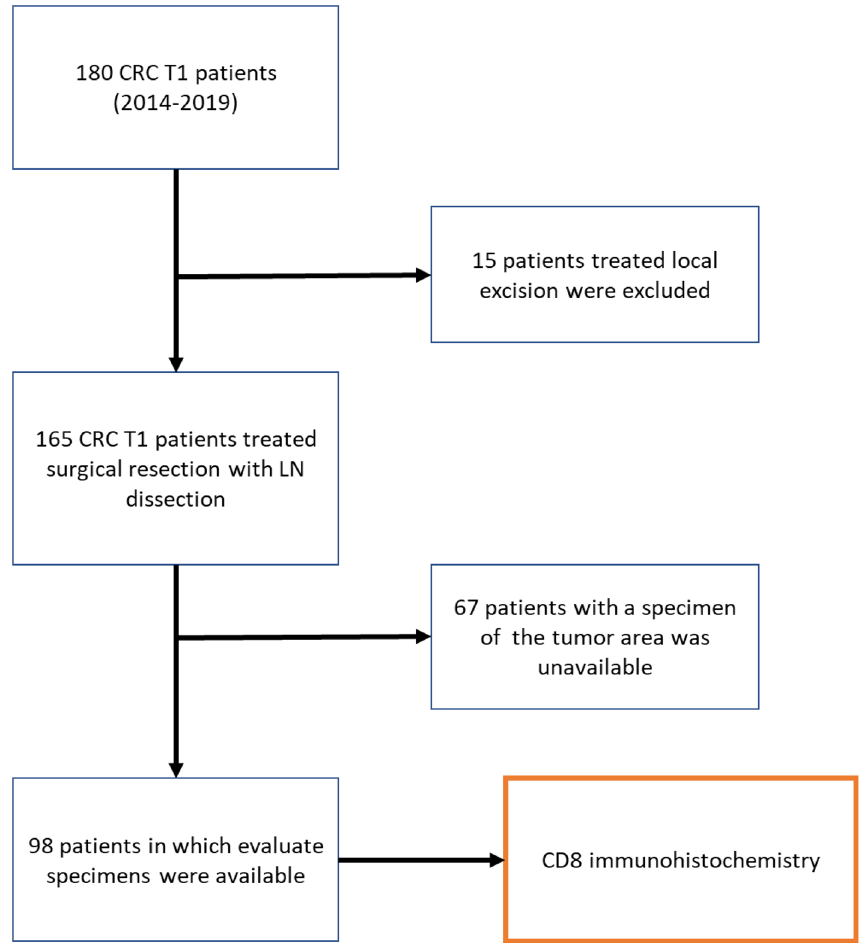
Figure 1. Scheme of the study. A total of 180 patients with surgically treated SM-CRC were enrolled in this study; 15 patients treated with local excision that lacked pathological lymph node metastasis data and 67 patients without available specimen of the tumor area were